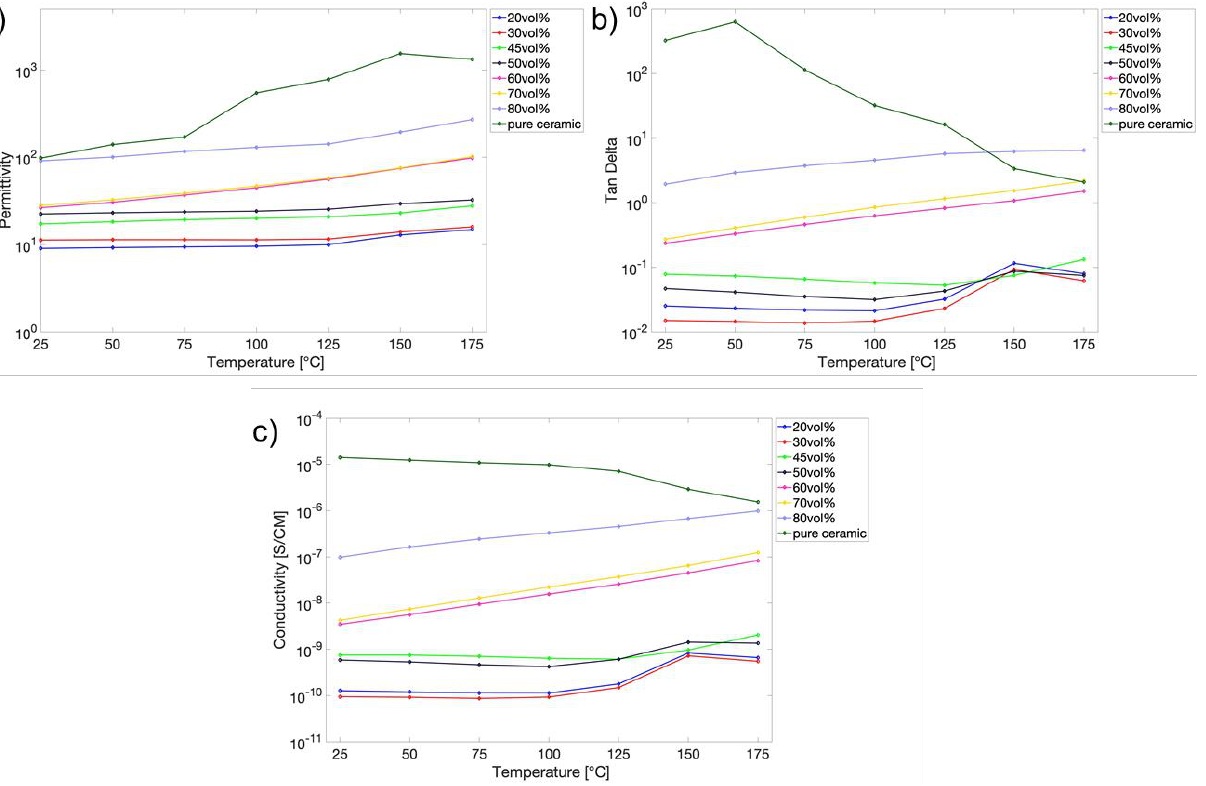
Figure 5. Temperature dependence of: ( a ) permittivity, ( b ) dielectric loss, and ( c ) conductivity of different vol% ZnO varistor-filled composites.